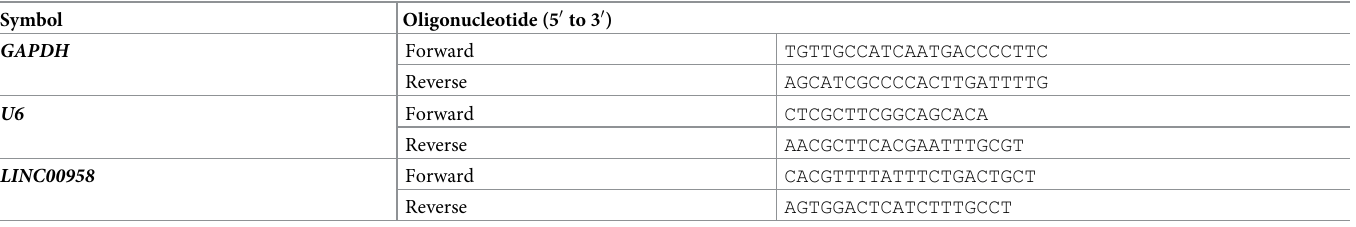
Table 1. Primer sequences for real-time fluorescence-based